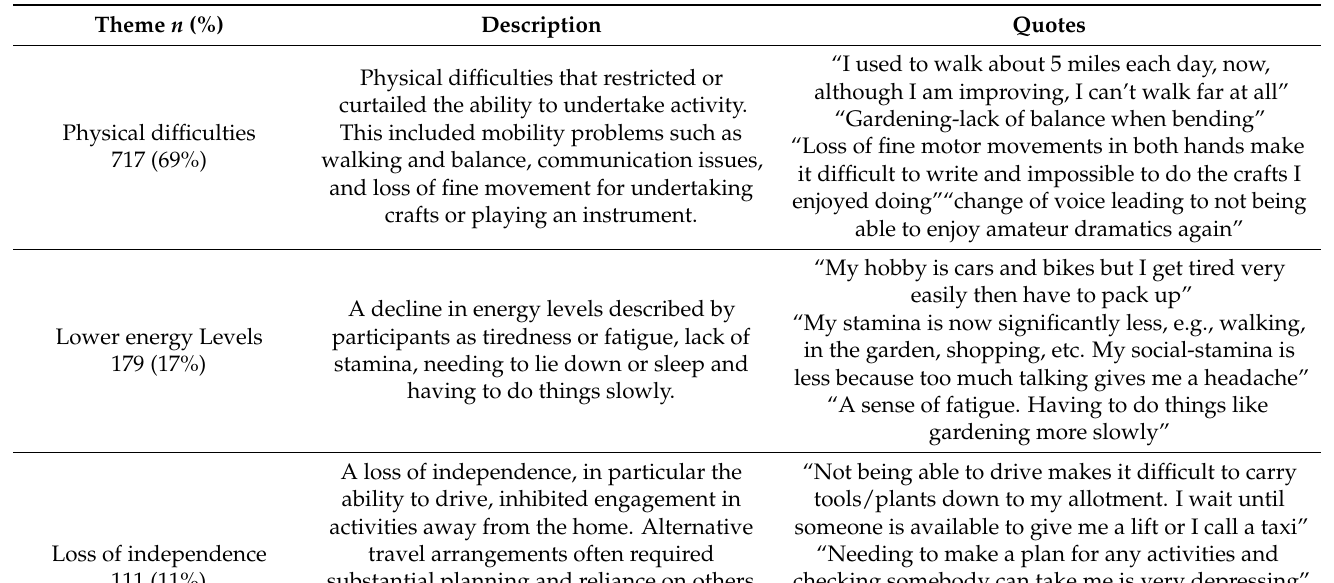
Table 2. Conceptual themes identified for barriers to activity at 6 month follow-up, number of participants in each theme and proportion of response